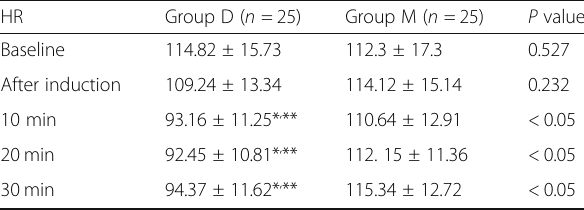
Table 5 Comparison of heart rate (beat/min) in the studied groups (data are presented as mean ± SD)